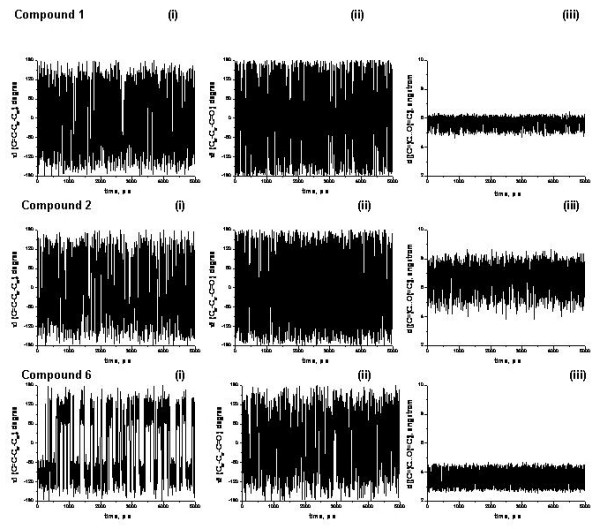
Ligand flexibility estimated from MD simulations for compounds 1, 2 and 6. The torsion angles around the aromatic ring, defined as τ 1(C = C-Car-Car) and τ 2(Car-Car-C = O), and the distance between the first carbon atom of the 1-heptenyl tail and the amide oxygen atom, defined as d [(C =)C...O(= C)] during a 5 ns MD simulation of compounds 1, 2, and 6. To resemble the highly hydrophobic environment within the binding pocket, the dielectric constant ε of 4.0 was used for the electrostatic interaction energy.